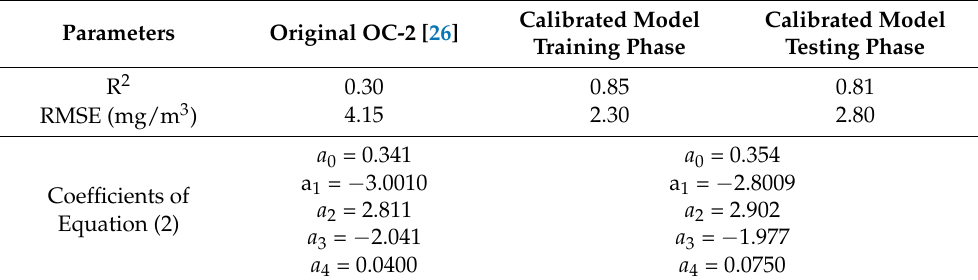
Figure 3. Scatter diagram of model predicted chl-a versus NOAA data; ( A ) in the training stage, ( B ) in the testing phase of the calibrated OC-2, and ( C ) of the uncalibrated OC-2. Table 2. Coefficient of determination (R 2 ) and root mean square error (RMSE) computed for training and testing phases, and a comparison of coefficients of the original OC-2 [26] and the calibrated model of this